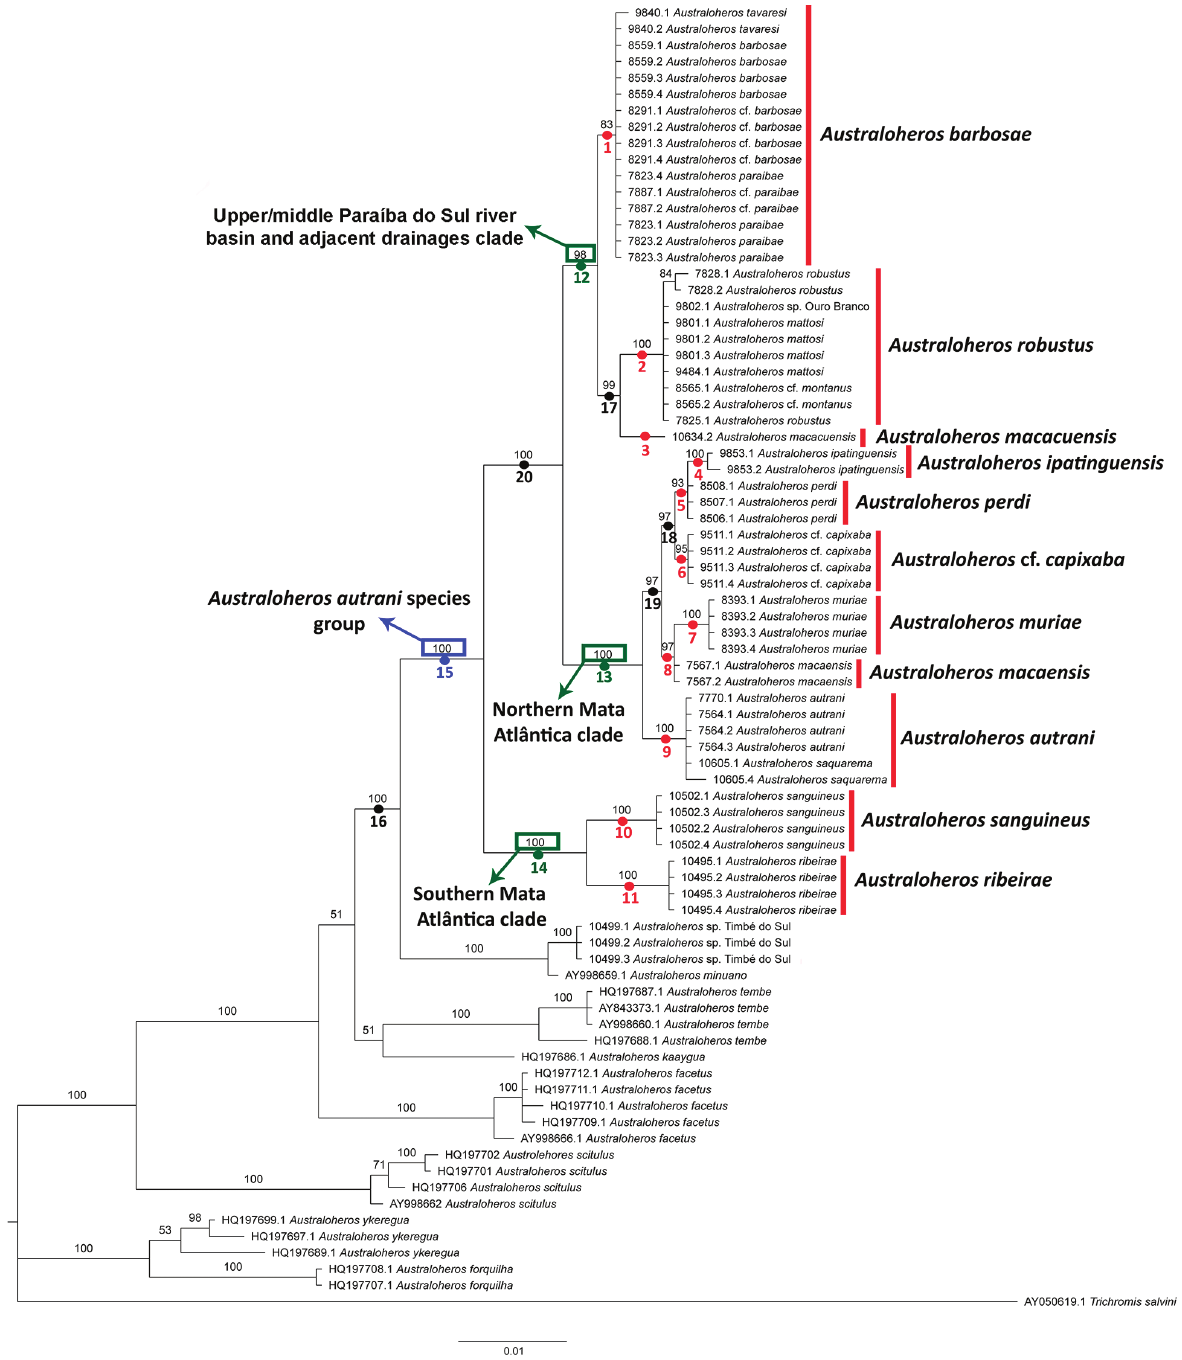
Figure 2. Phylogenetic haplotype tree based on Bayesian Inference (BI). Numbers above branches are posterior probability values, and below branches are numbered nodes which represent the combination of nucleotide substitution which define the species (in CBB) or clades. The nucleotide substitutions (CBB) can be checked in box1. Posterior probability value supporting the Australo- heros autrani group is indicated in blue, as well as, the three clades herein proposed within this species group are indicated in green. Species of the in-group delimited though the tree based method (WP) are indicated with red bars, as well as, the species of the in- group delimited by nucleotide substitution method (CBB) have their nodes marked in